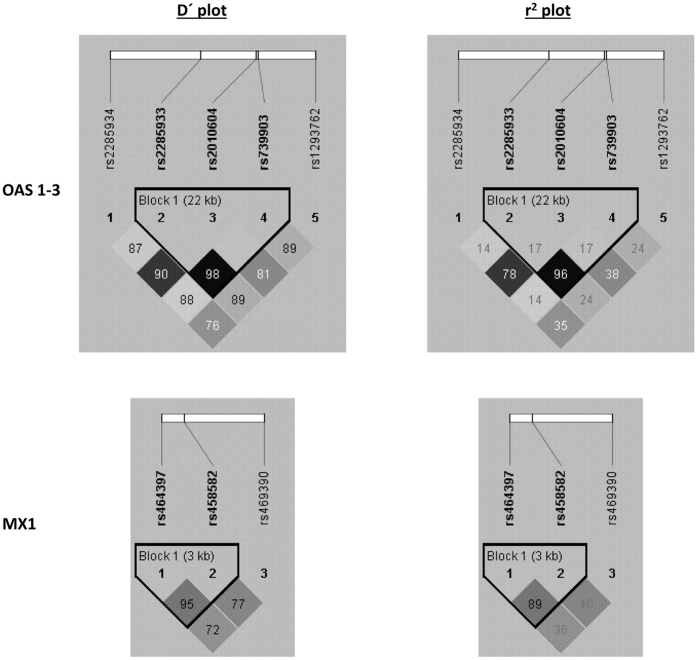
Pairwise linkage disequilibrium (LD) patterns for genetic polymorphisms of MX1 and OAS1-3.Each diagonal represents a different SNP, with each square representing a pairwise comparison between two SNPs. Abbreviations: OAS, 2′5′oligoadenylate synthetase; Mx1, myxovirus resistance proteins.